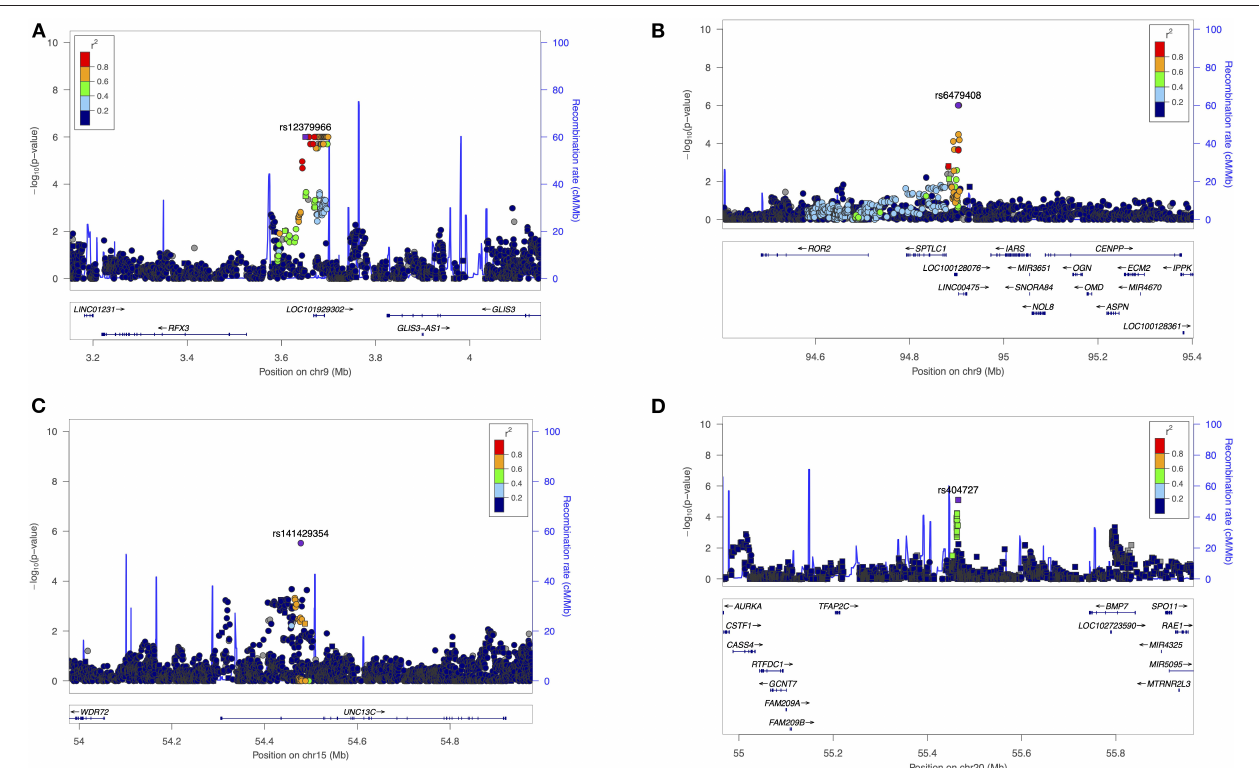
FIGURE 3 | Regional Association Plots from (HDR) results. LocusZoom were used to generate plots for regions of Interest. (A) Suggestive locus near GLIS3 on chromosome 9. (B) Suggestive locus near ROR2 and OMD genes on chromosome 9. (C) Suggestive locus near WDR72 gene on chromosome 15. (D) Suggestive locus near BMP7 on chromosome 20. The genome build used for the recombination rate was based on 1,000 Genomes November 2014 EUR data. All of the gene positions and directions of transcription are annotated on the